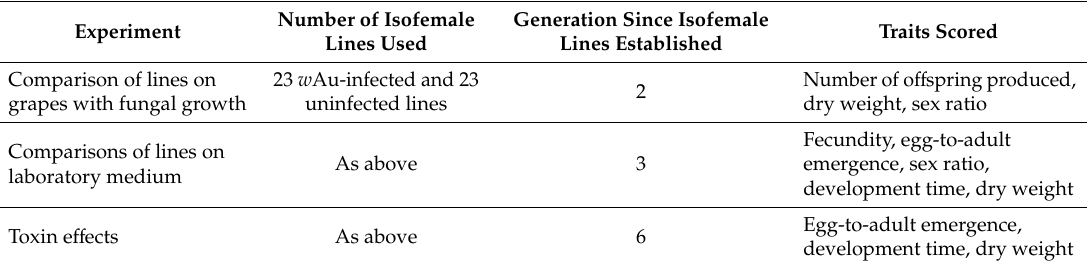
Table 1. Outline of experiments